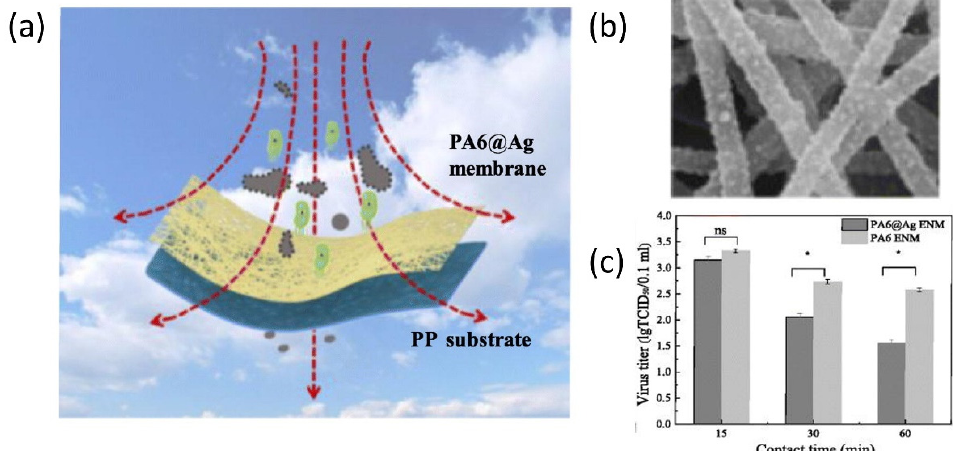
Figure 2. Responsive nanostructured materials for potential COVID-19 treatment and prevention. ( a ) Schematic illustration of nanostructured filter. ( b ) The SEM image of the nanostructured fibers decorated with Ag nanoparticles. ( c ) The viral titer measurement at different contact time. ns: not significant difference; * p < 0.05. Reprinted from [72], with permission from Elsevier Inc (Amsterdam, The Netherlands).